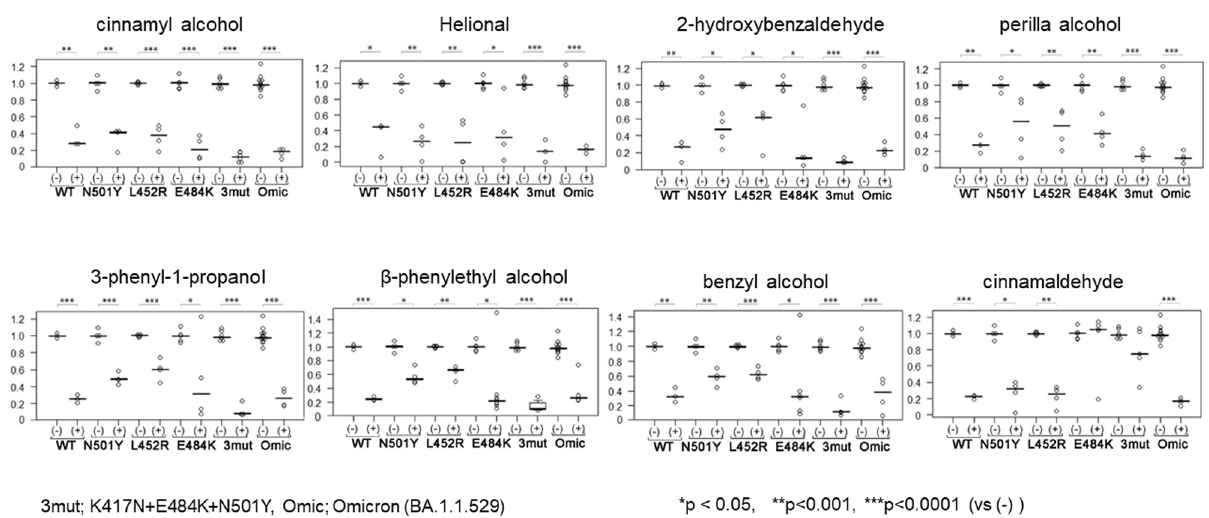
Fig 2. Inhibition of the binding of the variant vRBD to hACE2 by flavor/fragrance compositions. Relative binding of recombinant SARS-CoV-2 RBDs to recombinant hACE2 evaluated in 96-well plates with or without 0.5% (v/v) flavor/fragrance compositions: 0.5% DMSO was the solvent for each flavor/fragrance composition and used as the negative control (= 1.0). Three or more independent experiments were performed. Statistical differences between DMSO control and flavor/fragrance compositions prepared in DMSO compared using Student’s t -test. WT; wild-type (= Wuhan type), 3mut; K417N+E484K+N501Y (n = 3 [WT], n � 3 [N501Y, L452R, E484K, 3mut, and Omicron], � p < 0.01, �� p < 0.001, ��� p < 0.0001 compared with 0.5% DMSO control).